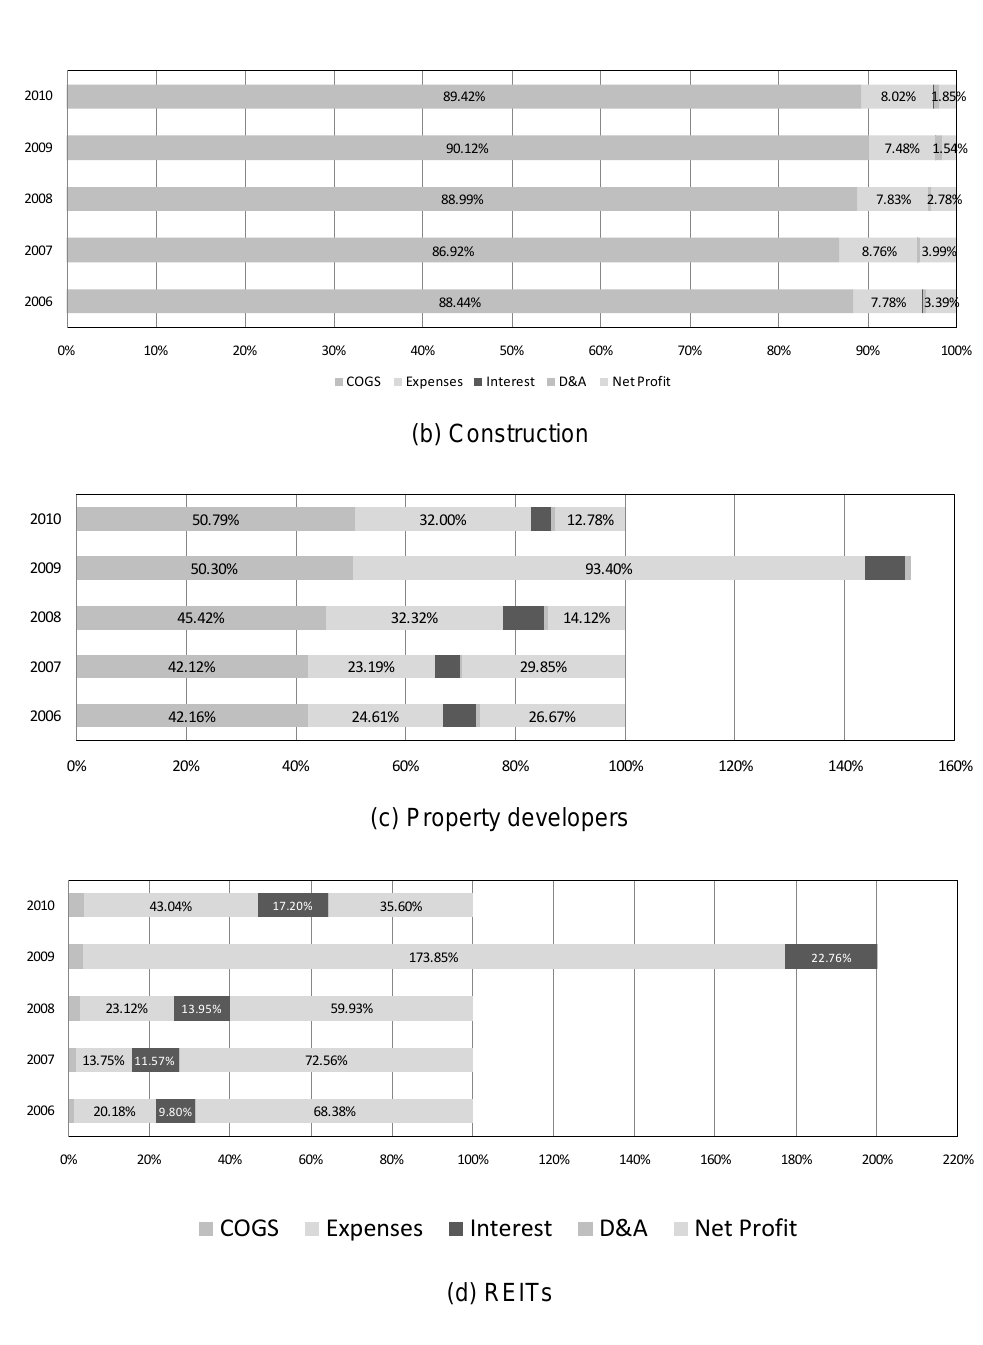
and REIT sectors (weighted based on